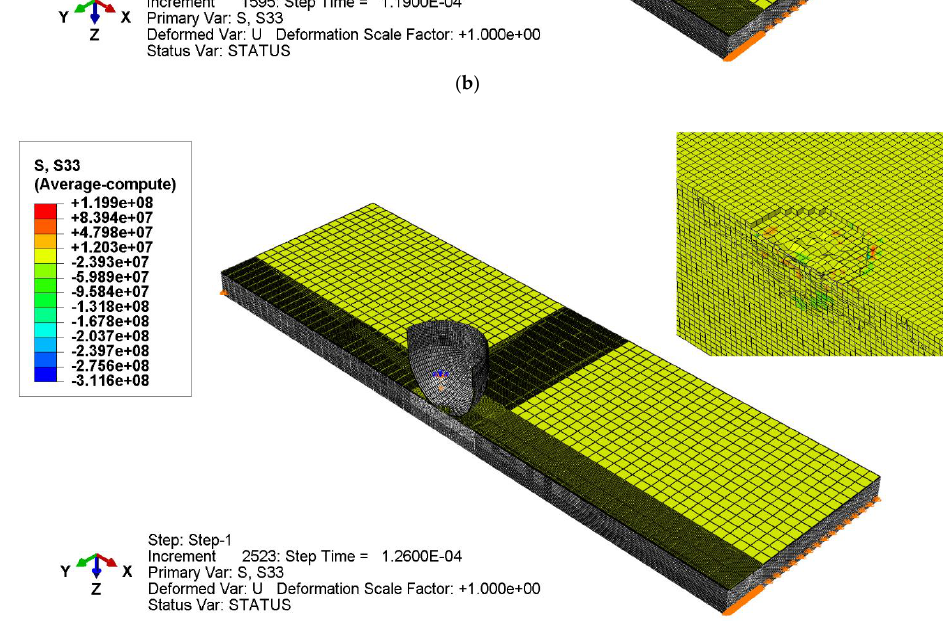
Figure 13. Local dent morphology for three impact energy cases.